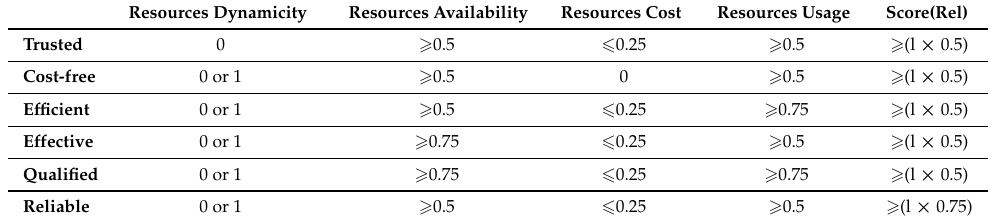
Table 1. QoR values and Score(Rel) necessary to form optimistic and hybrid compositions